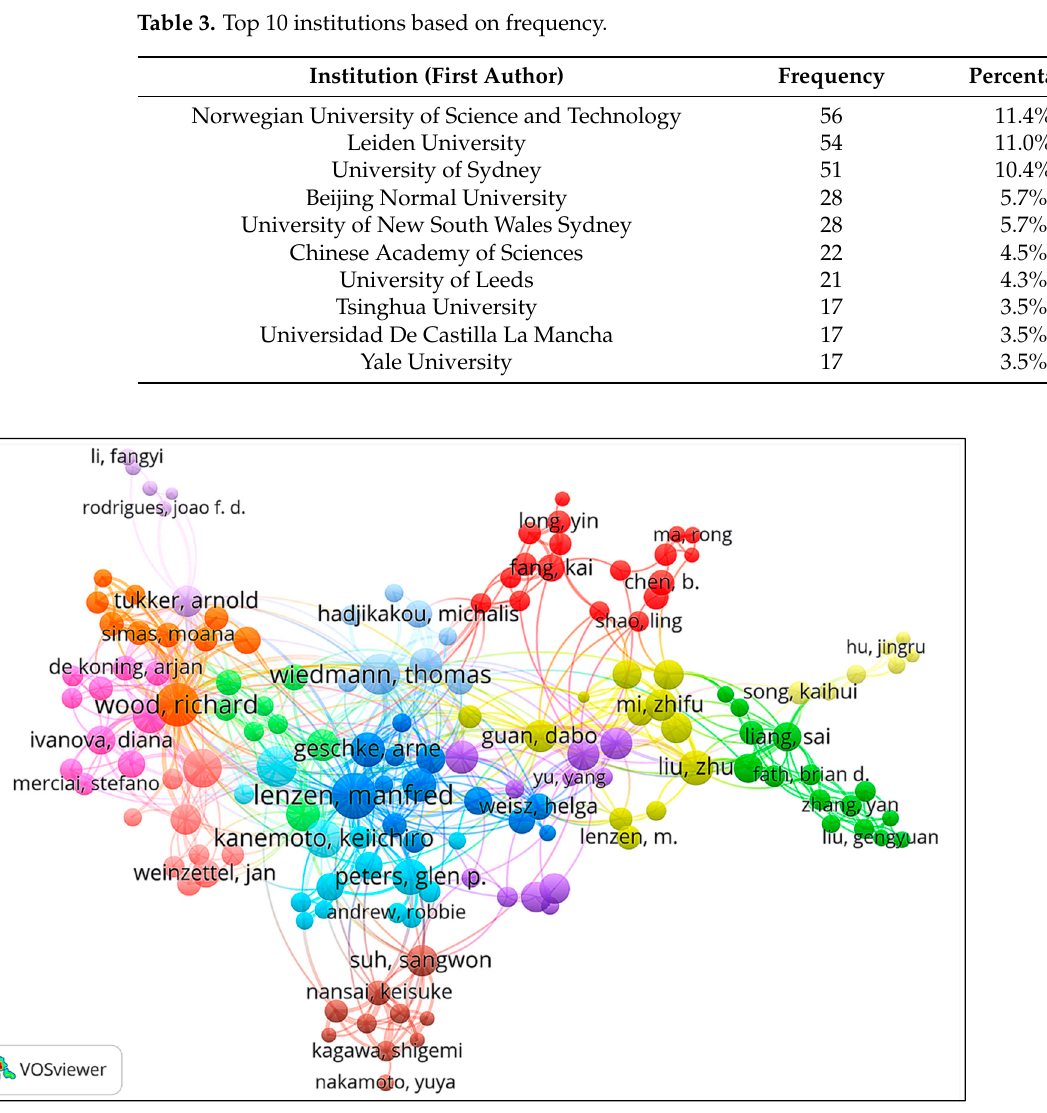
Figure 3. Network map of authors collaboration. Table 2. Top 10 countries (regions) based on frequency.